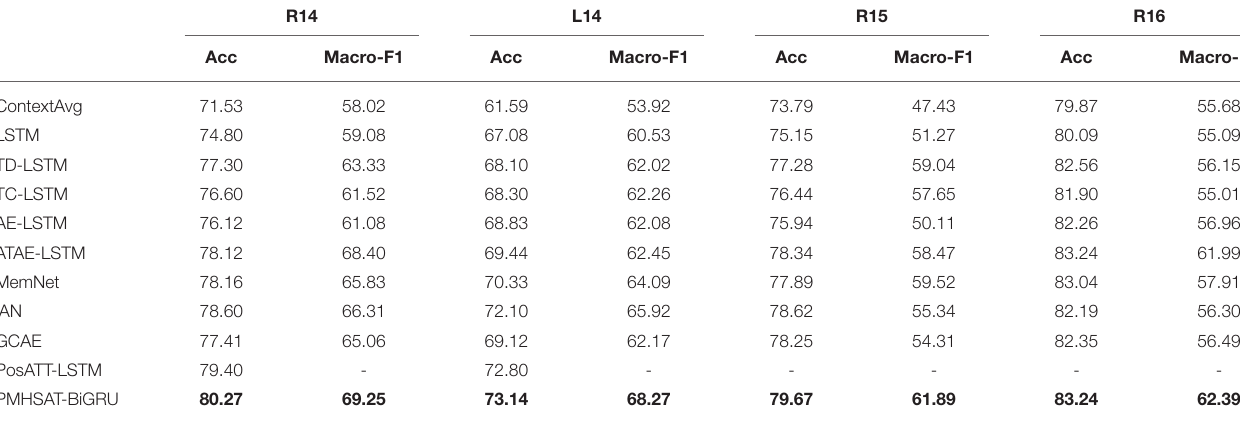
TABLE 4 | Analysis of position-enhanced multi-head self-attention based BiGRU model (PMHSAT-BiGRU) model. R14 L14 R15 R16 BiGRU 77.14 69.44 76.92 81.55 MHSAT-BiGRU 78.31 PMHSAT-BiGRU 83.24 The bold value indicates that the effect of this method is the best compared with other baseline models.